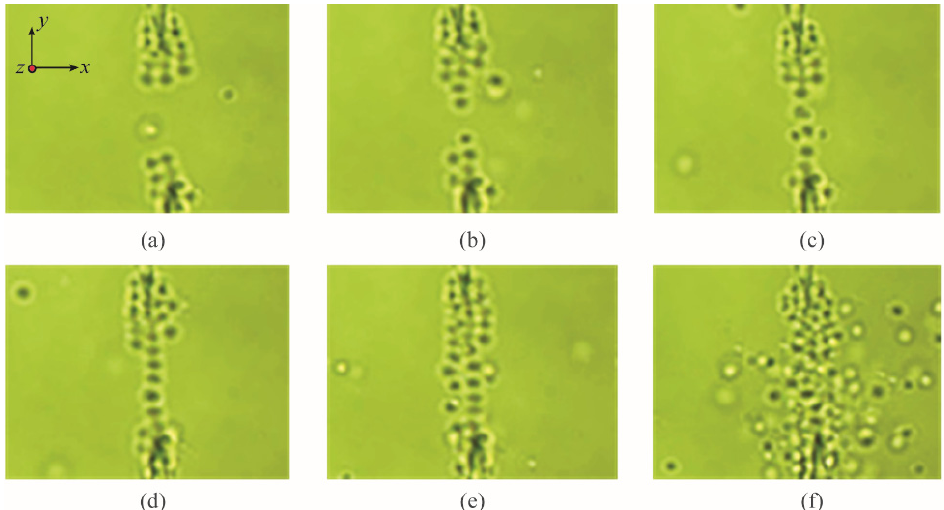
Figure 7. Massive particles trapping in two dimensions by a dual etched fiber system. Particles are trapped around both fiber tips at the beginning ( a ) and guided in a straight line due to the optical binding effect ( b – d ). Particles start to be guided in the second straight line (left) ( e ). ( f ) Generation of massive particles collection. The particles used in this experiment are silica beads with a size of 500 nm. The 100x oil immersion objective is used in this experiment. The two fibers are aligned along the y -axis in the yz plane and the submicron particles are guided along the y -axis in the xy plane.